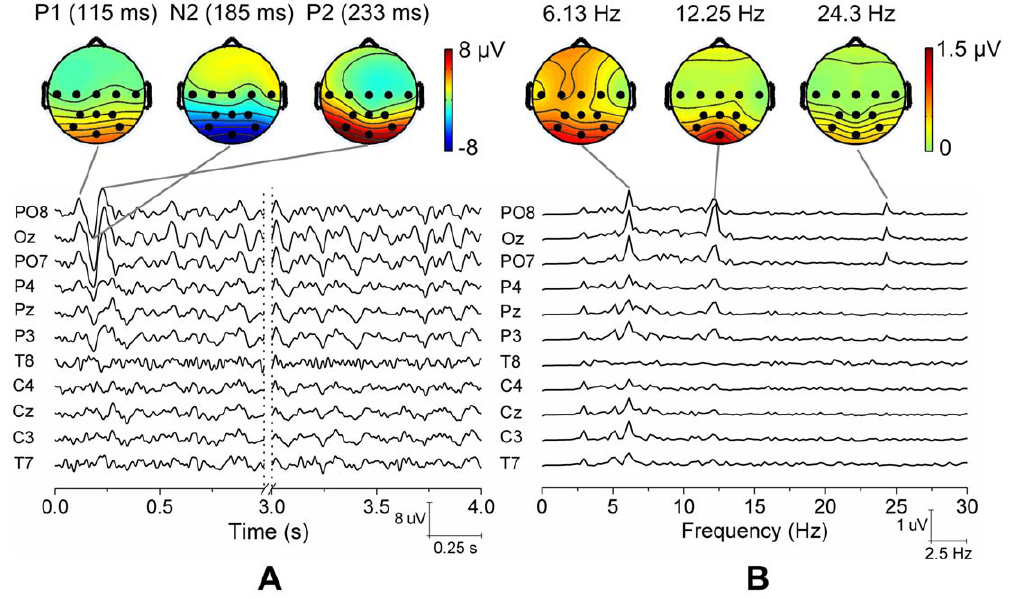
Figure 3. Time series and Topographies from eleven-channel mean SSMVEPs of subject S1. (A) Time series of the mean SSMVEPs. Topographic distributions exhibited symmetrical activations of the transient P1, N2 and P2 components. (B) Spectral topographies of three predominant frequency components of the mean SSMVEPs. The most activation area was also symmetrically located on PO7, Oz and PO8 sites.